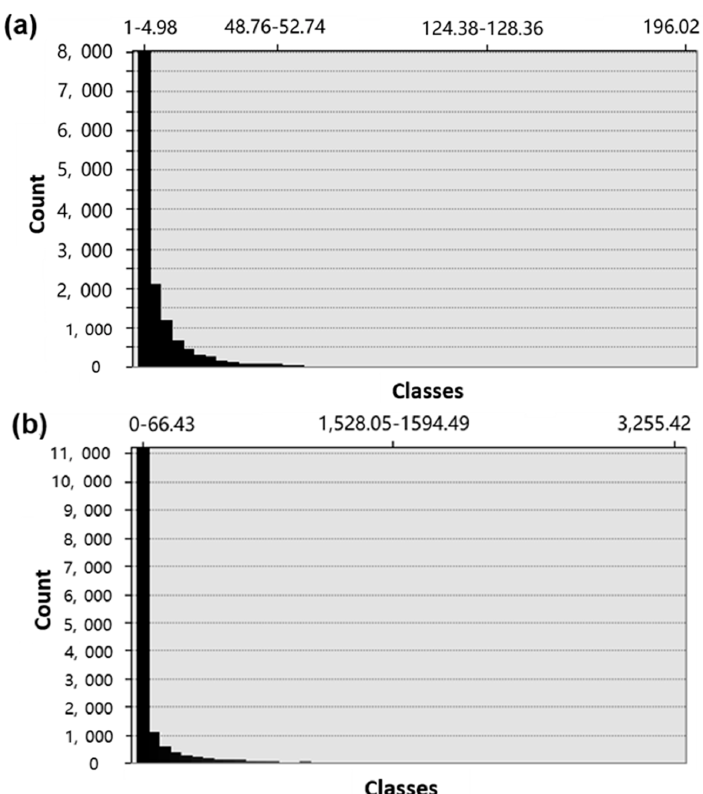
greater than 48, the count is almost 0. In Figure 7b, the range of density value is from 0 to 3321.854;